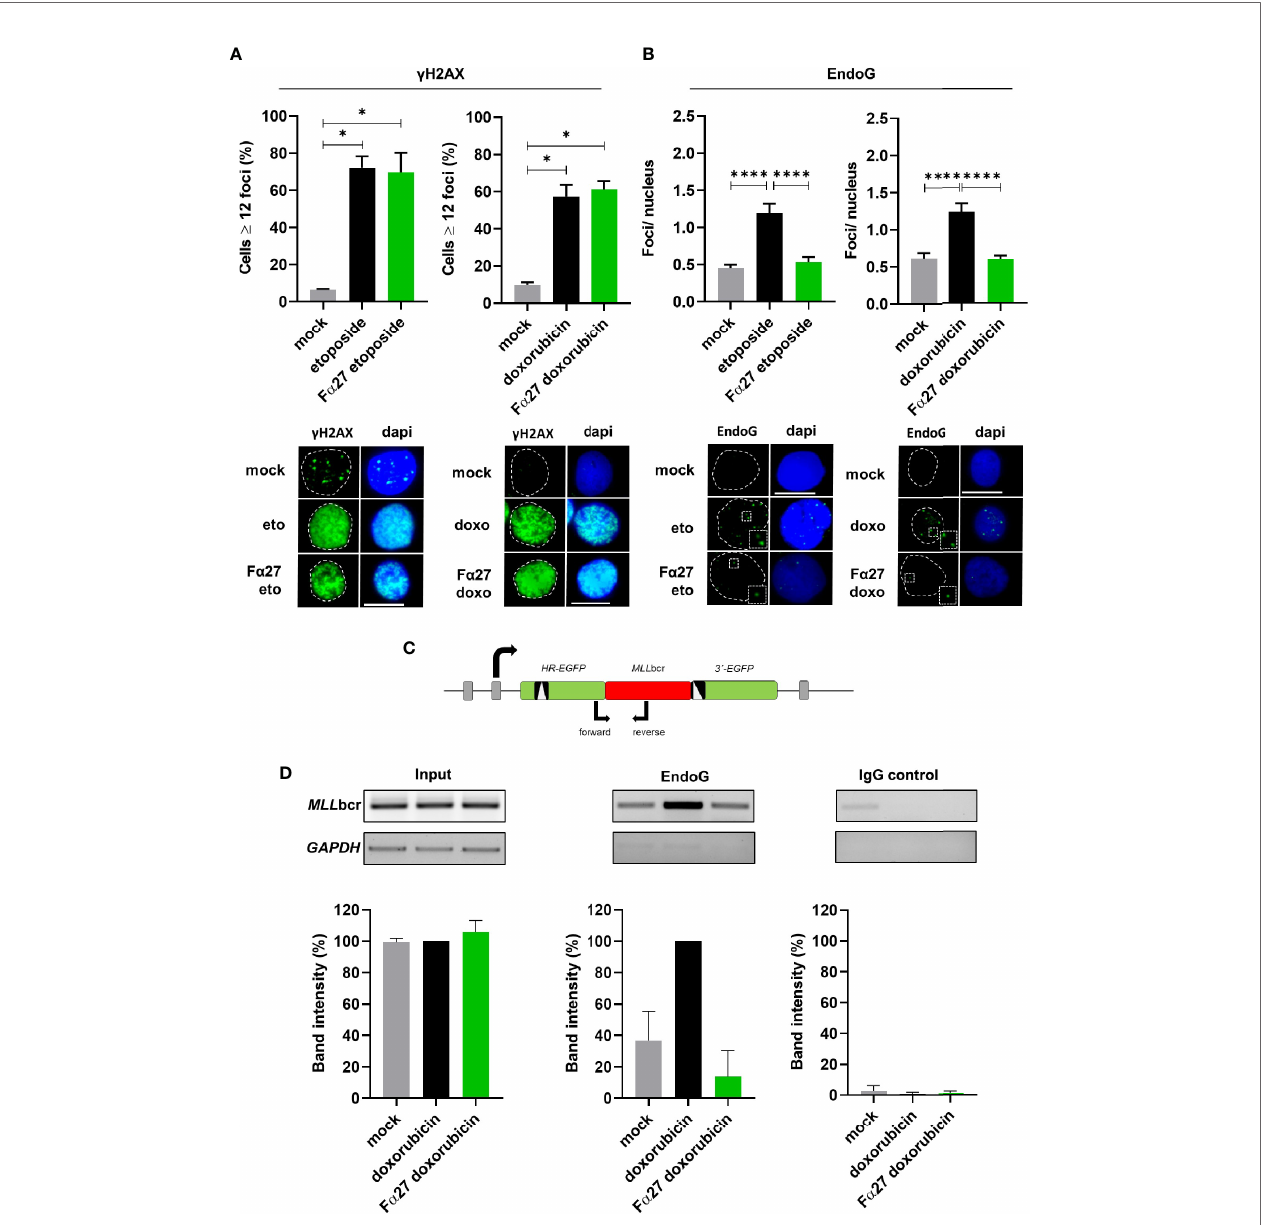
FIGURE 4 | F a 27 in fl uences EndoG accumulation in nuclear foci during treatment and reduces local EndoG binding to the MLL bcr. (A) No effect of F a 27 on nuclear DNA damage level during chemotherapeutic treatment. WTK1 cells were treated for 4 h with 1 mg/ml F a 27 followed by inclusion of 10 µM etoposide for 4 h or 10 µg/ml F a 27 for 4 h followed by inclusion of 0.5 µM doxorubicin for 4 h. Fixed cells showed an increase of cells with ≥ 12 g H2AX foci/nucleus after etoposide or doxorubicin treatment but no decrease with F a 27 pre-treatment (n=4 obtained in two independent experiments). (B) Decrease of nuclear EndoG signals by F a 27 treatment. WTK1 cells were treated as described in (A) and immuno fl uorescently labeled for EndoG detection. The nuclear EndoG signals increased after etoposide (n=294-463 obtained in two independent experiments) or doxorubicin (n=296-485 obtained in two independent experiments) treatments and F a 27 signi fi cantly decreased the nuclear EndoG level. Insets display the highlighted region at two-fold magni fi cation. Scale bars indicate 10 µM. White dashed lines encircle the DAPI- stained nucleus. All values represent mean +SEM (*p < 0.05; ****p < 0.0001). (C) Scheme of the MLL bcr region fl anked by two mutated EGFP genes. The scheme visualizes the positions of the primers used for PCR after chromatin immunoprecipitation (ChIP). To analyze the binding of EndoG to the MLL bcr a ChIP was performed. Soni fi ed DNA bound by proteins was immunoprecipitated with EndoG antibody or incubated with a control antibody. After DNA isolation a PCR was performed and band intensities evaluated. (D) Decreased EndoG binding to the MLL bcr after F a 27 treatment. WTK1MLL cells were treated for 4 h with 10 µg/ml F a 27 and additionally with 0.5 µM doxorubicin for 4 h. Two independent experiments for EndoG-ChIP and IgG-ChIP were performed. After PCR ampli fi cation of the MLL bcr in the recombination reporter, band intensities for input DNA and EndoG-ChIP samples after doxorubicin treatment were set to 100% and relative intensities calculated for the other samples including IgG-ChIP detected on the same membrane and with the same exposure time. EndoG binding to MLL bcr was increased after doxorubicin treatment and decreased with F a 27 treatment. Neither the input nor the control showed such a pattern. Control GAPDH PCR was positive for input but negative for ChIP samples. Data are shown as mean +SD. See also Figure S3